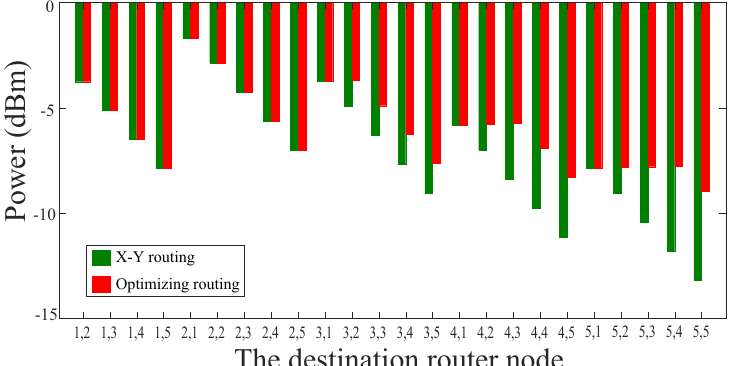
Figure 6. Signal power comparison between traditional routing algorithm and our optimization algorithm in a 5 × 5 mesh-based